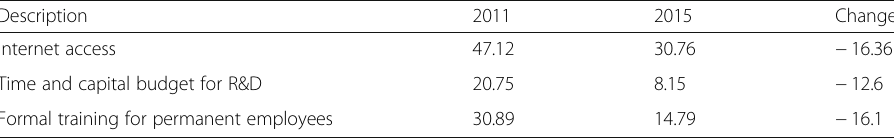
Table 5 Percentage of enterprises with access to inputs Description 2011 2015 Internet access Time and capital budget for